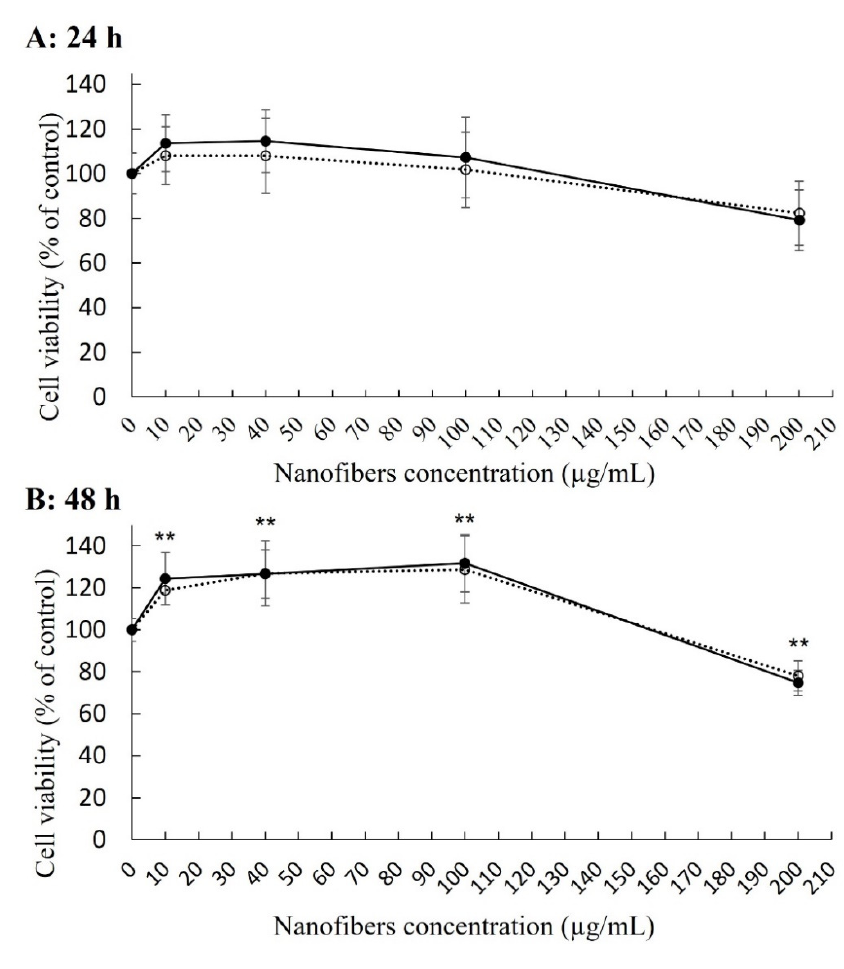
Figure 2. The effect of SiO 2 nanofiber (SiO 2 NFs) lengths on the cytotoxic response. Cytotoxicity of L-SiO 2 NFs ( ○ ) or S-SiO 2 NFs (•) detected by WST-1 assay. Data were collected after 24 h (plot A ) and 48 h (plot B ) of treatment of THP-1-derived macrophage-like cells with different concentrations of SiO 2 NFs. Statistical analysis was performed by one-way analysis of variance, ** p = 0.005 ( n > 6).